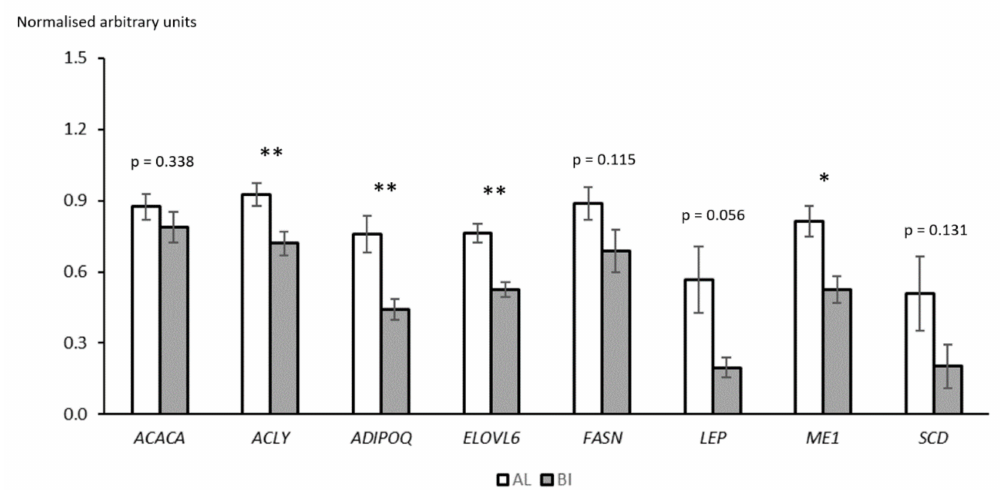
Figure 3. Estimated relative expression of candidate genes involved in lipid metabolism in the Longissimus lumborum of Alentejano (AL) and B í saro (BI) pigs ( n = 5 for each genotype) through Real Time qPCR. ACACA (Acetyl-CoA carboxylase alpha), ACLY (ATP citrate lyase), ADIPOQ (Adiponectin), ELOVL6 (Elongation of long-chain fatty acids family member 6), FASN (Fatty acid synthase), LEP (Leptin) , ME1 (Malic enzyme 1) , SCD (Stearoyl-CoA desaturase). Represented values are means of relative gene expression with their respective standard errors represented by vertical bars. Significance: ** p < 0.01, * p <